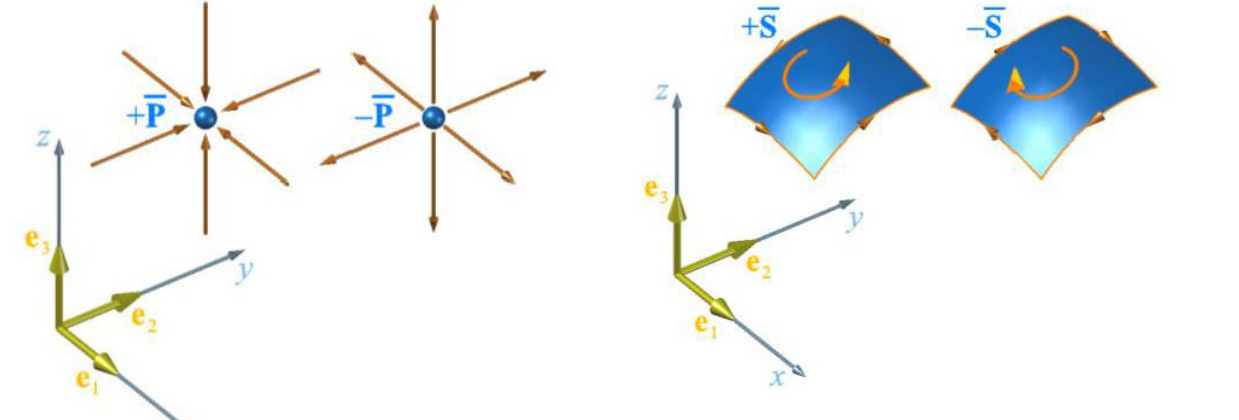
to each direction of the three-dimensional space, the point is orthogonal to the three-dimensional space itself and to each volume of the space.